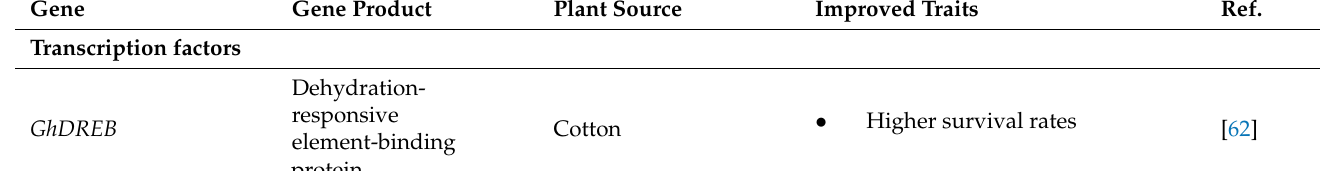
Table 4. Improvement of cold and freezing tolerance in wheat plants through transgenic approaches. Gene Product Plant Source Improved Traits